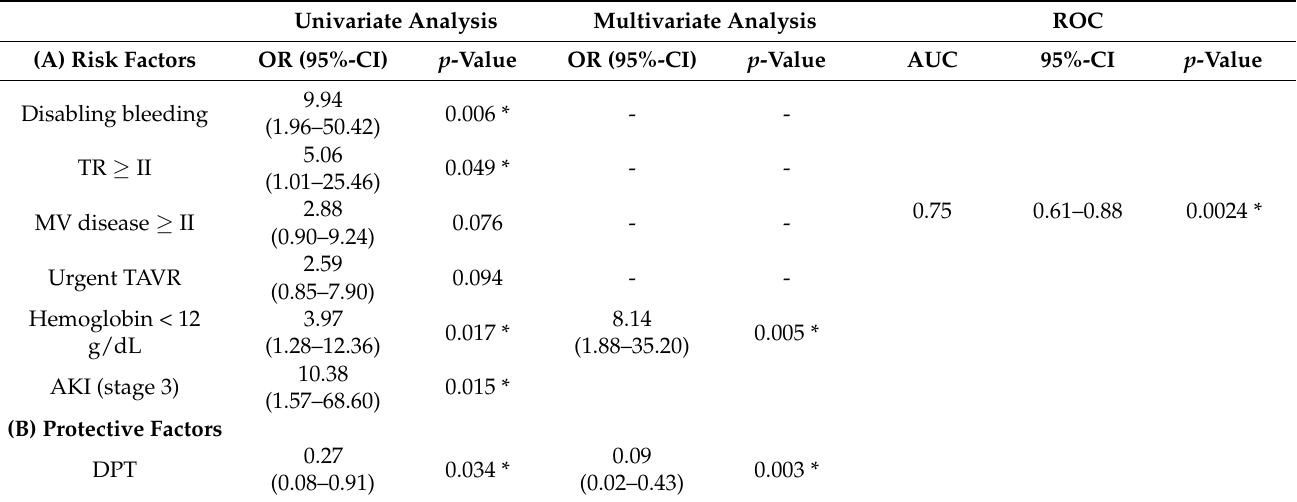
Table 4. Univariate and multivariate regression analysis of 1-year mortality. Univariate Analysis Multivariate Analysis